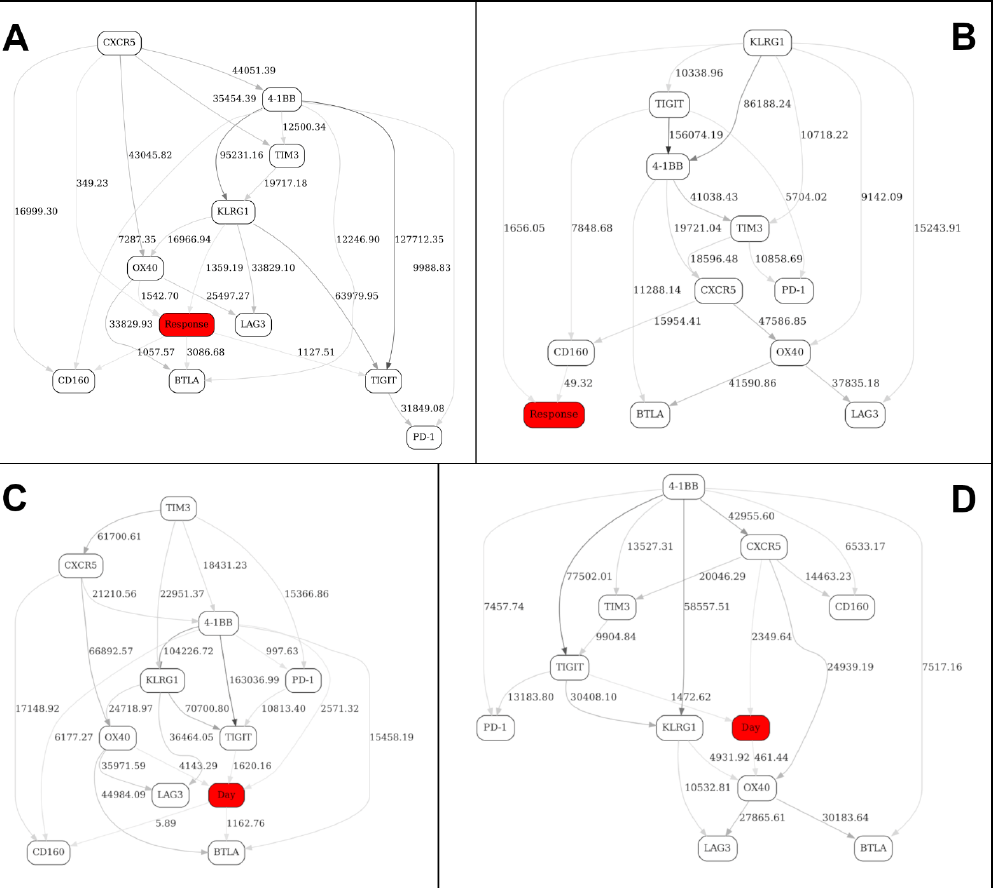
Figure 6. Contrast BNs constructed from FACS data (Checkpoint panel, Non-naïve CD4+ T cells subdataset) from 13 patients. ( A ) at day 1, responders vs. nonresponders, ( B ) at day 21, responders vs. nonresponders, ( C ) nonresponders, at day 1 vs. day 21, and ( D ) responders, at day 1 vs. day 21. “Day” node is the indicator variable with two states (day 1, day 21). “Response” node is the indicator variable with two states (response, nonresponse). See Figure 1 legend for further details.